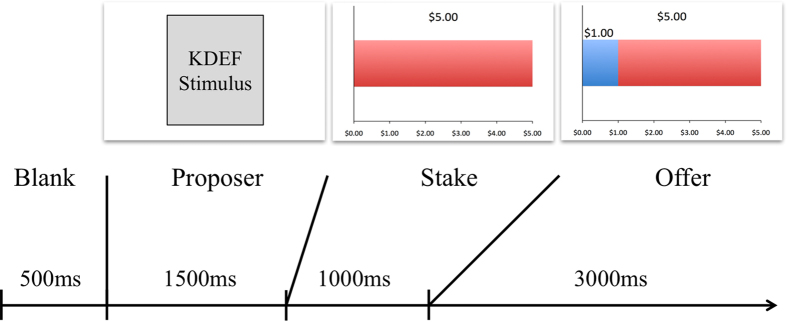
UG task structure.Following a blank screen, participants viewed a picture of the supposed proposer (an image from the Karolinska Directed Emotional Faces picture set, omitted here), the total stake ($5.00 in this case), and the proportion of the stake that was offered ($1.00 in this case). Participants either accepted or rejected the offer during the offer period. This trial structure repeated 24 times, each with a unique proposer, with varying stake and offer sizes.